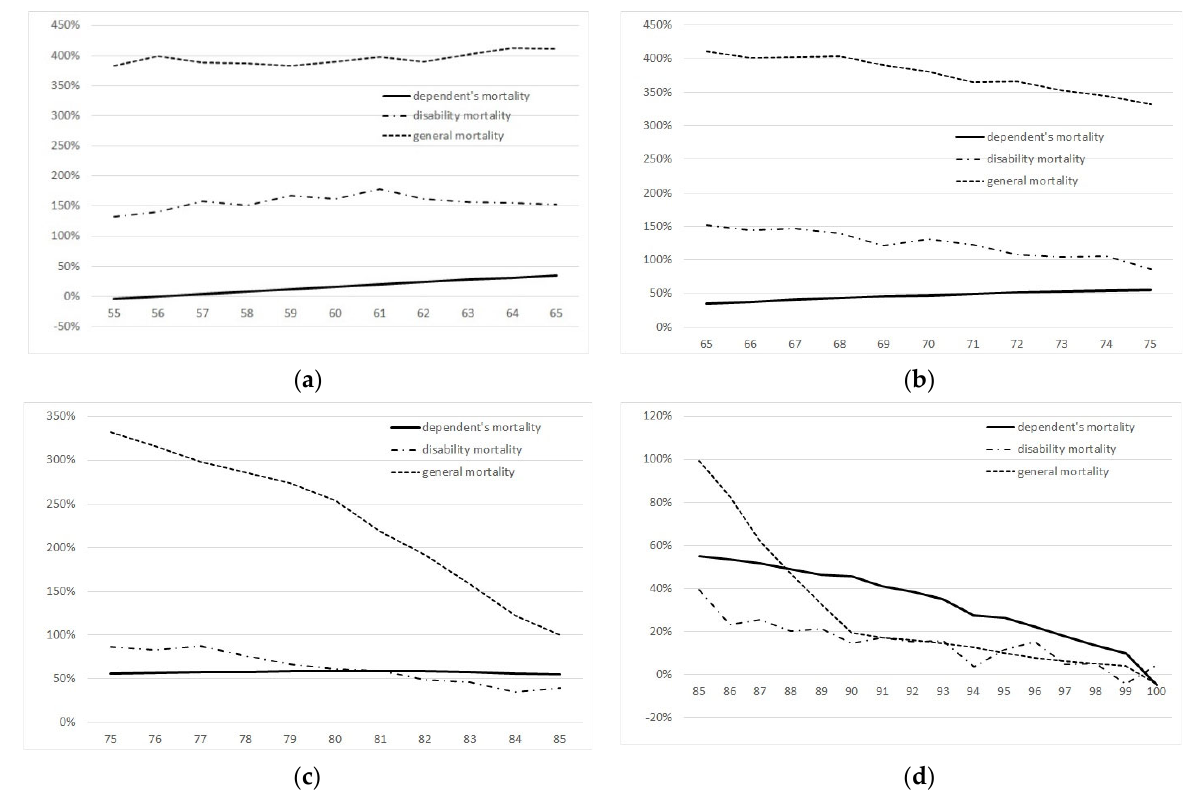
Figure 4. Existing excess mortality in each state by gender and age ( a ) 55 to 65 years; ( b ) 65 to 75 years; ( c ) 75 to 85 years; ( d ) 85 to 100 years. Source: Own work. Database: PERM/F 2000 mortality tables for the general population [64]; Spanish social security actuarial tables for disability [65]; severe and high dependency mortality tables in Spain [71].